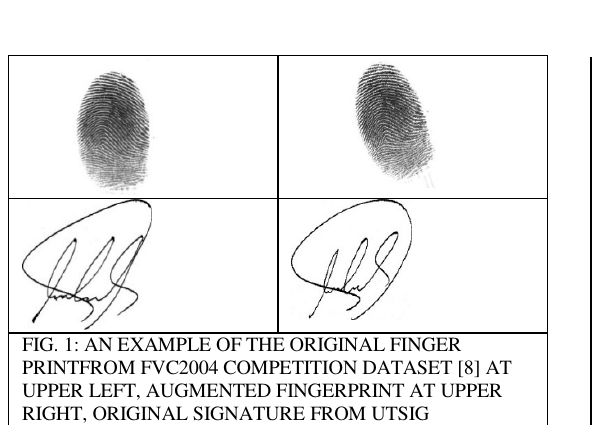
FIG. 1: AN EXAMPLE OF THE ORIGINAL FINGER PRINTFROM FVC2004 COMPETITION DATASET [8] AT UPPER LEFT, AUGMENTED FINGERPRINT AT UPPER RIGHT, ORIGINAL SIGNATURE FROM UTSIG DATASET [9] AT LOWER LEFT AND AUGMENTED SIGNATURE AT LOWER RIGHT